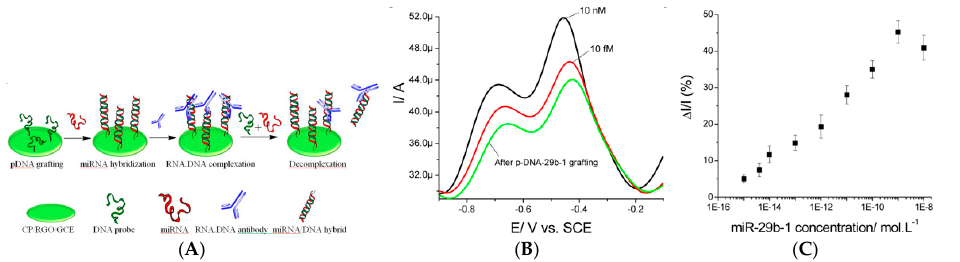
Figure 15. ( A ) Description of miRNA immunosensing; ( B ) SWVs after pDNA-29b-1 probe grafting, after hybridization with 10 fM miR-29b-1 and with 10 nM miR-29b-1; ( C ) Calibration curve: Δ I / I (%) vs. miR-29b-1 concentration. Medium: PBS. Relative current changes were calculated as follows: I = Ibefore hybridization and Δ I = I after hybridization − I before hybridization . Adapted with permission from [89]. Copyright 2013 American Chemical Society.